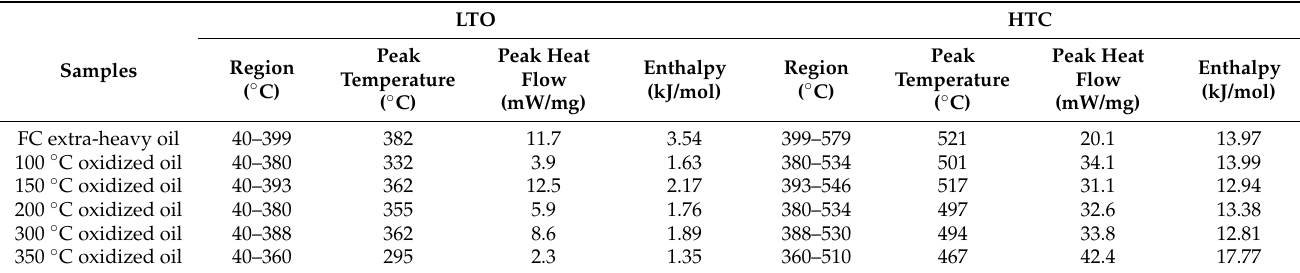
Table 5. DSC parameters of FC extra-heavy oil and oxidized oils at 10°C/min.